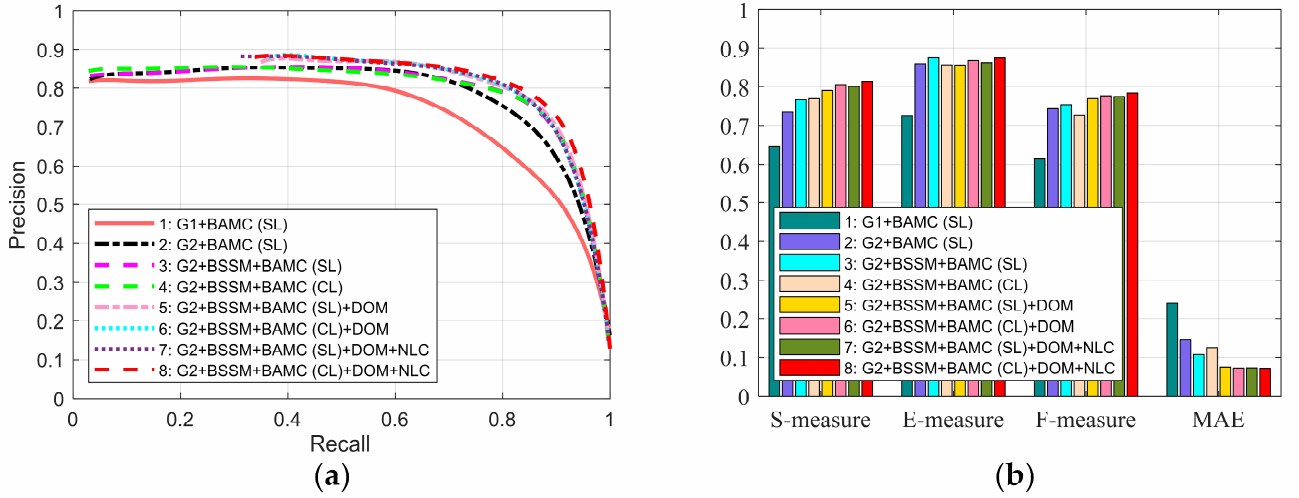
Figure 9. Valuation of different components. ( a ) PR curves. ( b ) S-measure, E-measure, and F-measure at adaptive threshold, mean absolute error (MAE). G1: two-layer graph; G2: two-layer spare graph; BAMC (SL): bilateral absorbing Markov chain based on single-modal multi-graph learning (color mode), CL: cross-modal multi-graph learning model (color and depth modes); BSSM: background seed screening mechanism; DOM: depth-guided optimization model; NLC: non-local connection.